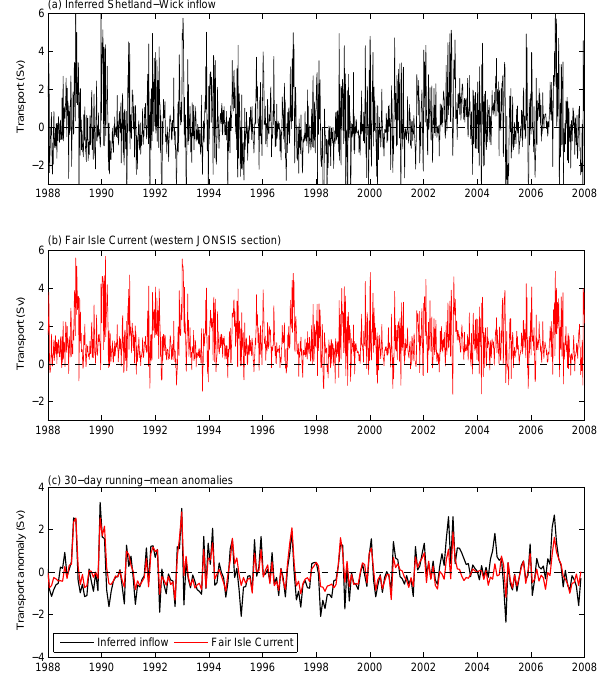
Figure 9. Transports related to Atlantic inflow into the northwest North Sea: (a) inferred inflow between Shetland and Wick, 5-day averages; (b) transport in the Fair Isle Current between 1.10 and 2.46 ◦ W at 59.27 ◦ N (along the western JONSIS line), 5-day av- erages; (c) 30-day running mean of anomalies in inferred Atlantic inflow and Fair Isle Current